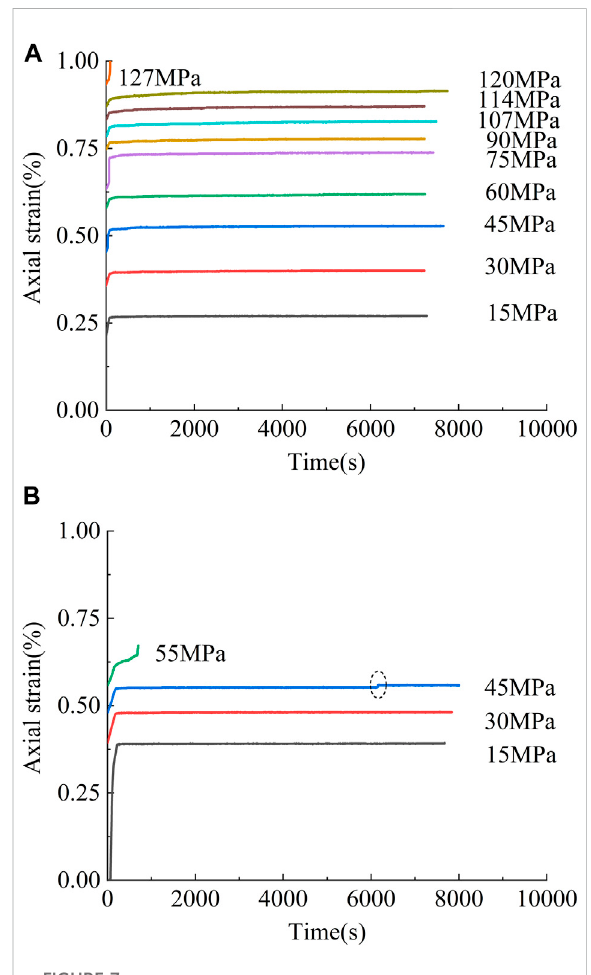
FIGURE 7 Creep Curves of sandstone specimen under respective loading. (A) Intact specimen. (B) Prefabricated fi ssures specimen.